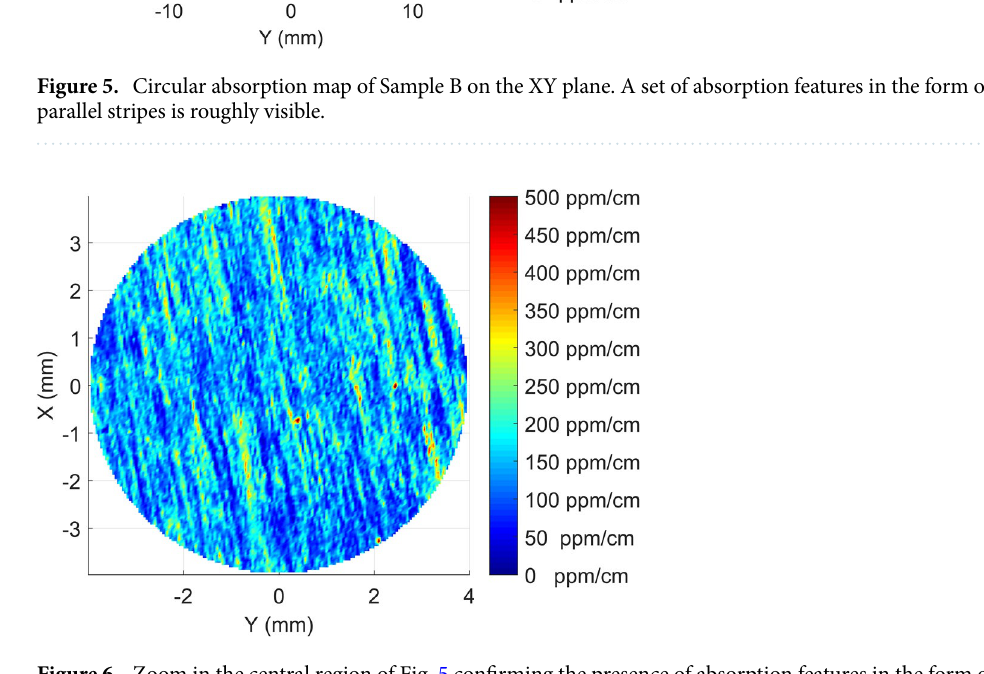
Figure 6. Zoom in the central region of Fig. 5 confirming the presence of absorption features in the form of parallel